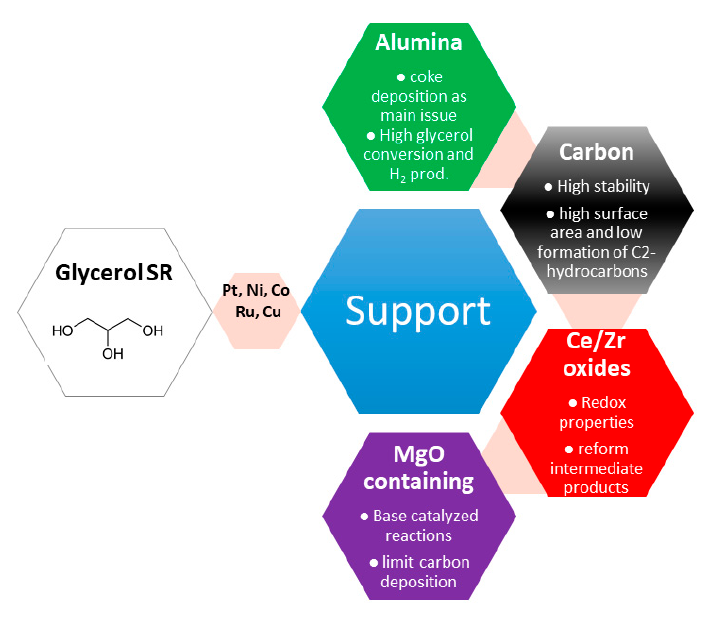
Figure 3. The most used supports in glycerol steam reforming (SR) and their main features.